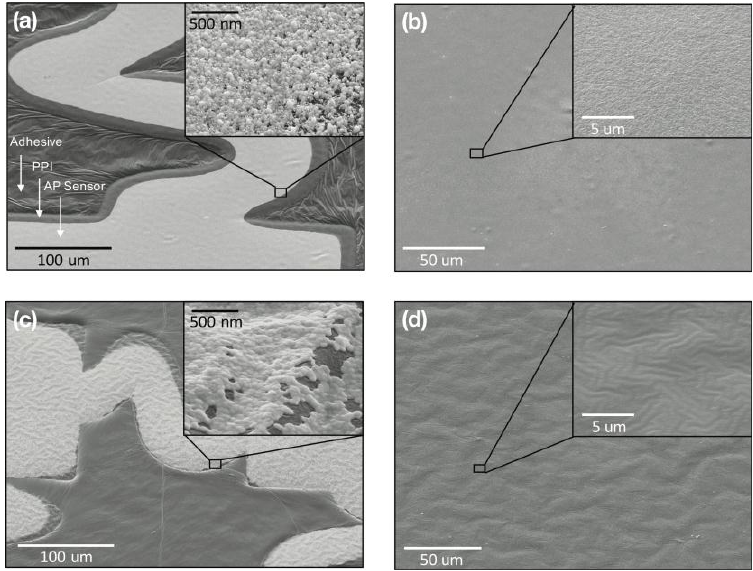
Figure 5. SEM images of evaporated and sputter-coated AP sensors: ( a ) evaporated sensor on adhesive film; ( b ) weakly-adhering PDMS surface after evaporated sensor peel-off; ( c ) sputter-coated sensor on adhesive film; ( d ) weakly-adhering PDMS surface after sputter-coated sensor peel-off; and ( insets ) Zoomed-in surface definition of respective